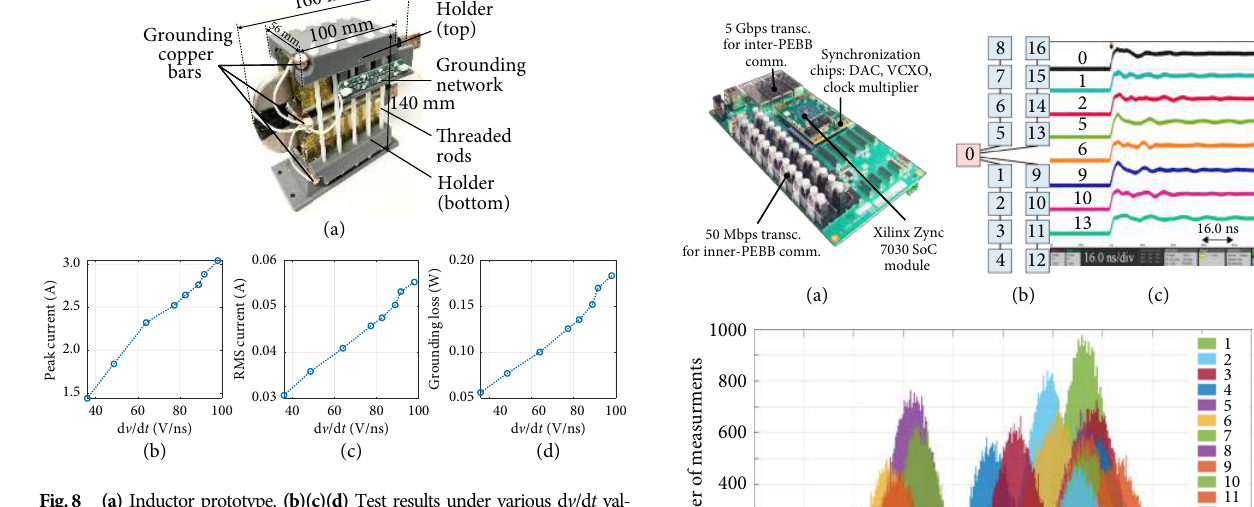
Fig. 8 (a) Inductor prototype. (b)(c)(d) Test results under various d v /d t val-